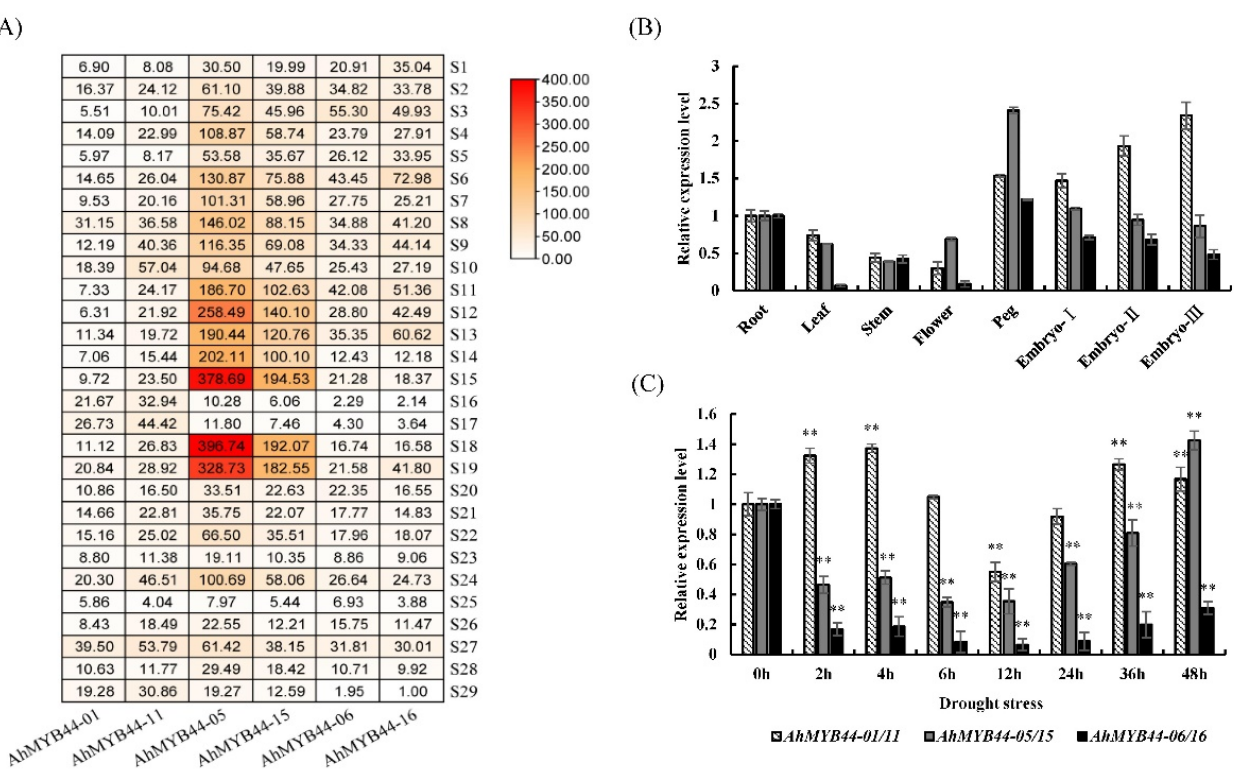
Figure 2. Expression patterns of AhMYB44s in tissues and responses to different stresses. ( A ). Expression patterns of AhMYB44s in tissues and responses to different Transcription profiling of AhMYB44s in different tissues or organs of peanut and in leaves after different stress treatments. S1: cotyledon; S2: leaf; S3: florescence; S4: gynophore; S5: root; S6: root